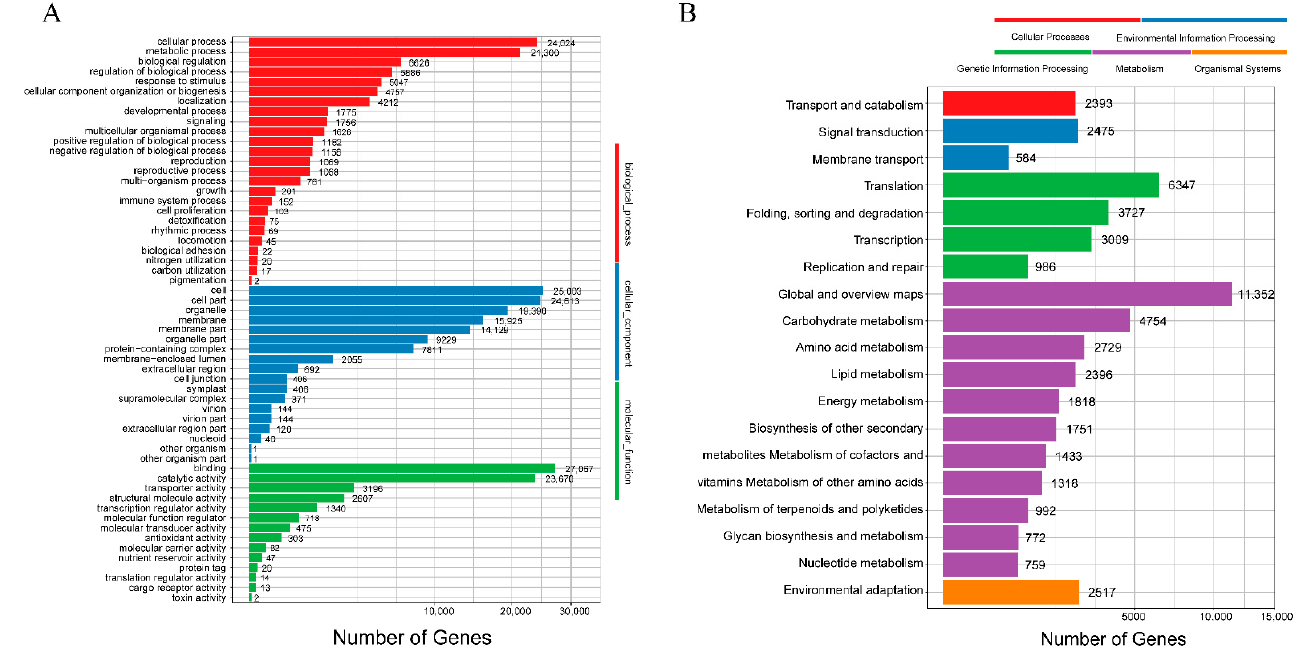
Figure 3. Classification of the assembled unigenes. ( A ) GO classification of unigenes; ( B ) KEGG classification of classification of unigenes.